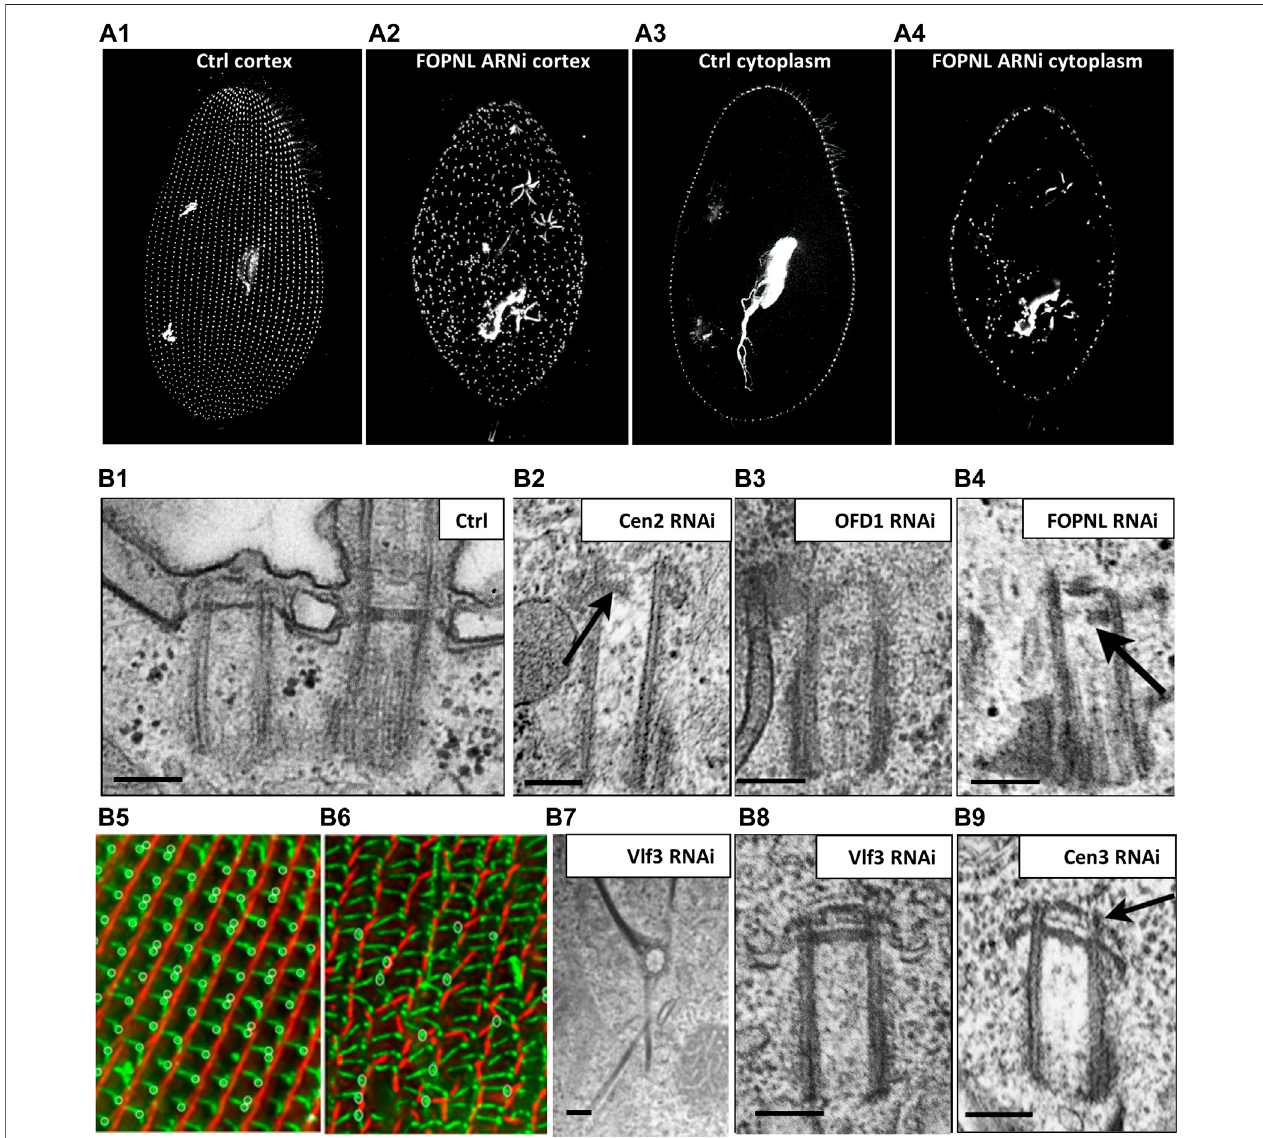
FIGURE 7 | Paramecium , a model to study basal body anchoring defects. (A) A1-A4: Control Paramecium (A1, A3) and FOPNL-depleted Paramecium (A2, A4) decorated for basal bodies (ID5 antibodies) observed by confocal at the cell cortex (A1, A3) or at intracytoplasmic level (A2, A4). Note that FOPNL depletion leads to a disorganizedpatternofbasalbodies atthe cellcortex. Unanchored basalbodies arefound inthecytoplasm(A4)(reproduced/adapted withpermission "Aubussonet al, 2012.Journalofcellscience,125,4395-440"). (B) Transmissionelectronmicroscopicimagesofabasalbodydoubletanchoredatthecellsurface.NotethattheTZ varyinheightbetweentheciliatedbasalbodyandtheunciliatedone(B1).B2-B4:DepletionofCentrin2(B2),OFD1(B3)(reprintfromBengueddachetal,2017,Cilia6,6. doi:10.1186/s13630-017-0050-z), and FOPNL (B4) lead to unanchored basal bodies with defective organization of its distal end (reproduced/adapted with permission Aubusson et al, 2012. Journal of cell science, 125, 4395-4404). B5-B6: immuno fl uorescence of a control Paramecium (B5), or cell depleted for SF-assemblin depleted group-Iproteins(B6)fromNabietal.,2019withpermission,stainedforthekinetodesmal fi ber(red)andmicrotubulerootlets(green).Notethedisorganizationofthebasal bodies and mis-orientation of their rootlets at the cell surface (Nabi et al., 2019). Depletion of V fl 3 protein (B7) induces the formation of more than one kinetodesmal fi ber indicating rotational polarity defect (reprint from Bengueddach et al, 2017, Cilia 6, 6. doi:10.1186/s13630-017-0050-z). By contrast, the distal end of the basal body is well organized as after depletion of Centrin3 (B9) (reproduced/adapted with permission Aubusson et al, 2012. Journal of cell science, 125, 4395-4404). Scale bars: 250